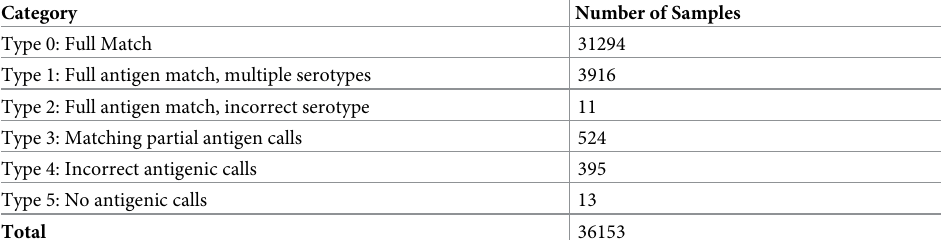
Table 1. Draft genome assemblies were queried for the presence of the SGSA v. 2 probe sequences and the sequence identities were converted into simulated probe signal values. These simulated values were processed using the array classifier and the antigenic formula and serotype were compared to the reported serotype for the assembly. Records were assigned to five different categories as described in the materials and